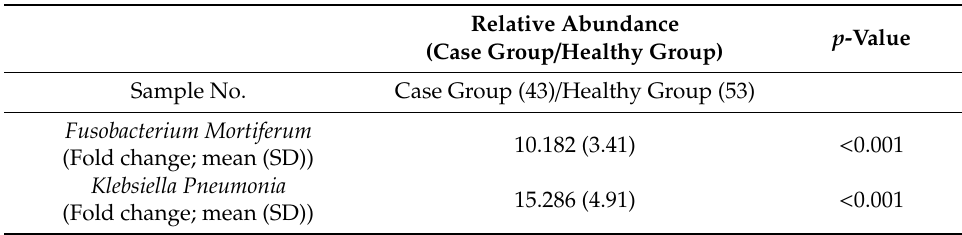
Figure 5. Characterization of identified taxa in adenomatous polyp participants and healthy subjects using LEfSe analysis. ( A ) The relative abundances of the top 30 classified OTUs to species level in healthy group (left) and adenomatous group (right) with MinION data. ( B ) Histogram of the LDA scores computed for OTUs with differential abundance in the healthy subjects and the participants with adenomatous polyp (case group). Table 3. Statistical results of identified taxa with MinION results to the species level in the adenomatous polyp and healthy